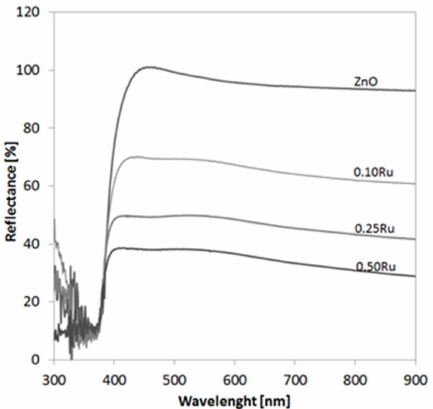
Figure 3. UV–Vis DRS spectra of undoped and Ru-modified ZnO photocatalyst in terms of reflectance as a function of